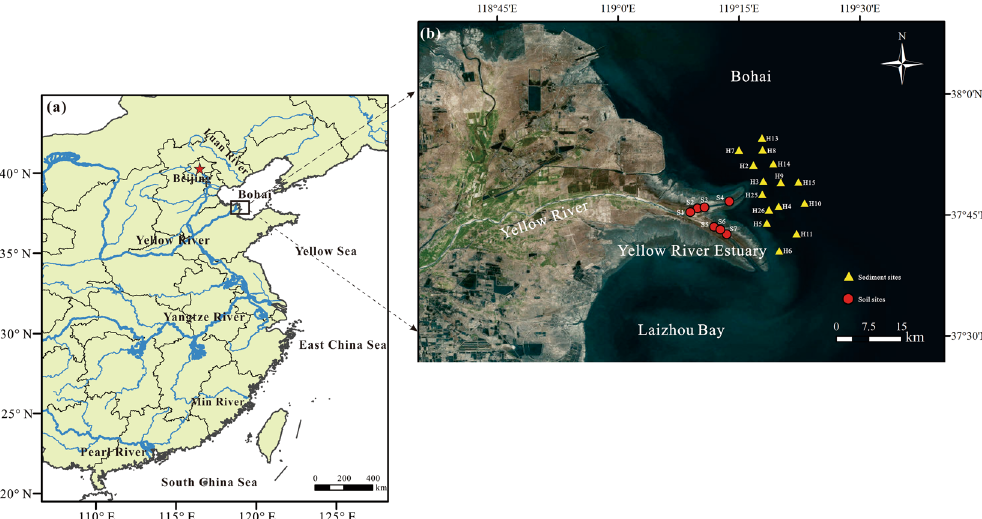
Figure 6. Map of (a) the large Chinese river-estuarine systems and (b) the Yellow River Estuary with the sampling sites. The figure was generated using ArcGIS 10.2 software